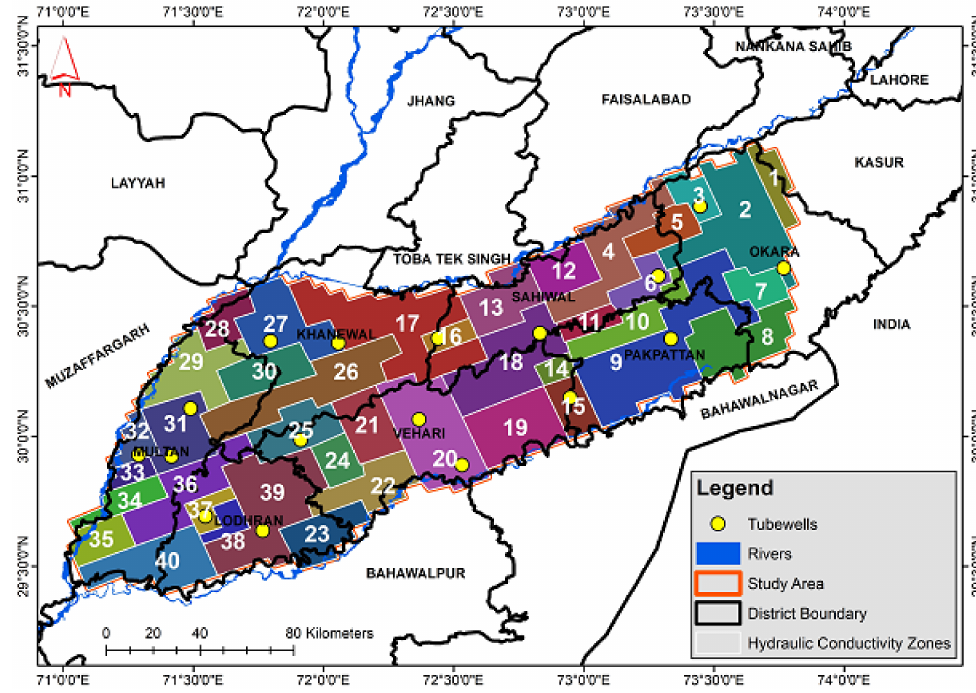
Figure 7. Zonation of adjusted hydraulic conductivity (K model ) of the aquifer.